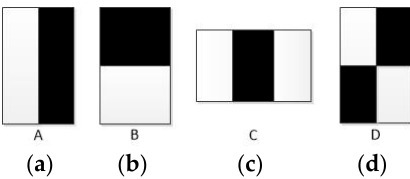
Figure 1. Four Haar-like feature operators. ( a ) Two-rectangle feature where rectangular regions are horizontally adjacent; ( b ) Two-rectangle feature where rectangular regions are vertically adjacent; ( c ) Three-rectangle feature; ( d ) Four-rectangle feature.